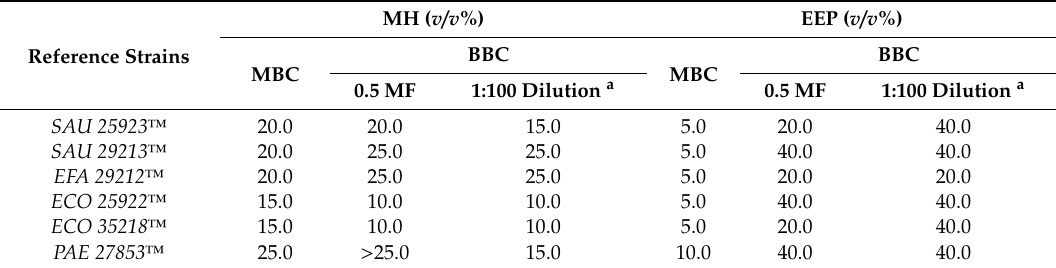
Table 1. Minimal bactericidal concentration (MBC) and biofilm bactericidal concentration (BBC)